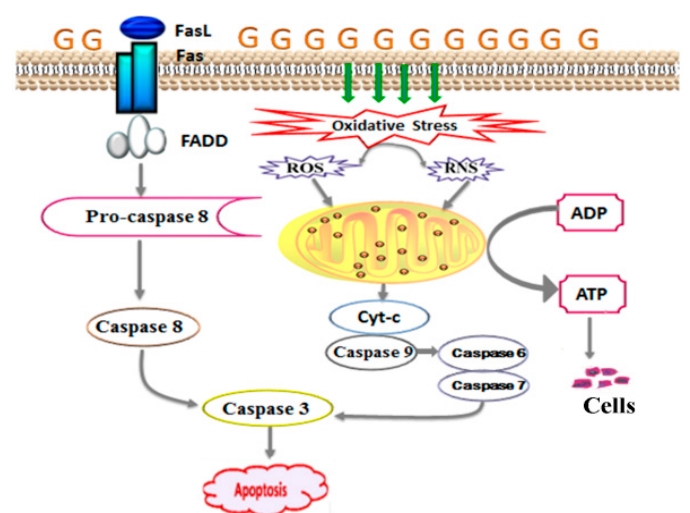
Figure 8. The signaling pathway of apoptosis. Hyperglycemia leads to the production of reactive oxygen species (ROS) and reactive nitrogen species (RNS) which change the membrane potential of mitochondria, leading to the release of cytochrome C (Cyt-c). It also leads to the expression of Fas ligand (FasL) and Fas, and they combine to form the Fas-associated death domain protein (FADD). The Cyt-c and FADD all activate caspase cascade reaction, leading to apoptosis.